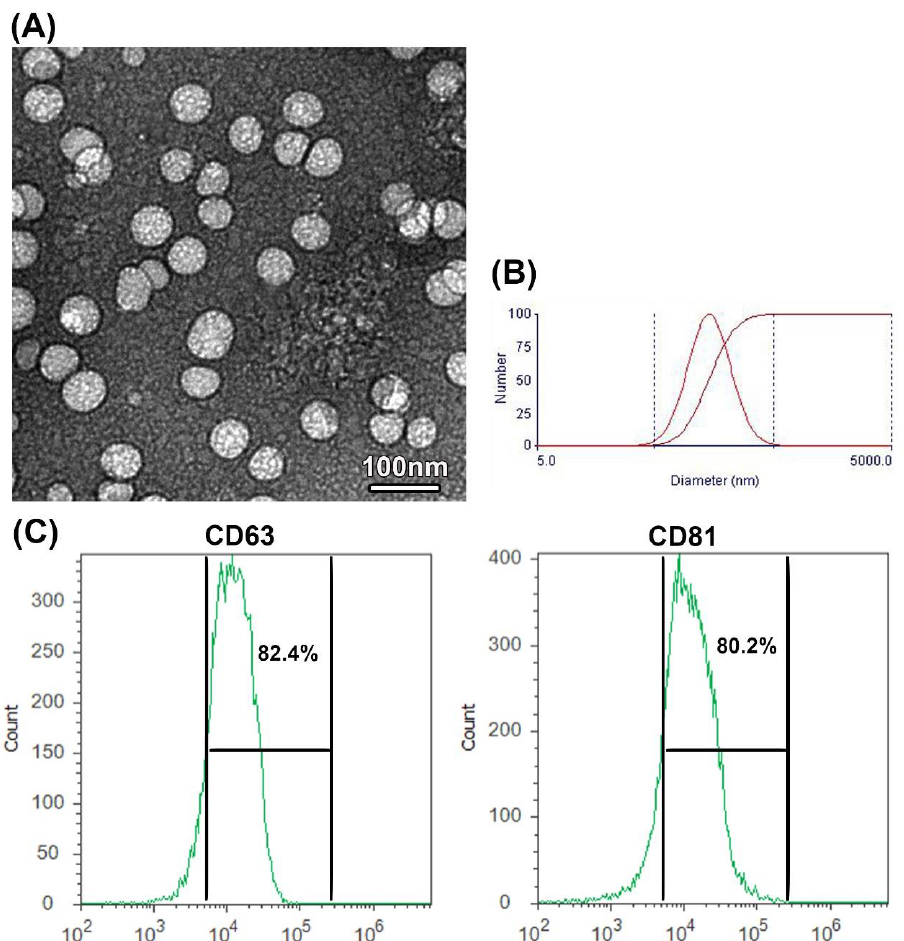
Figure 1. Characterization of EXOs isolated from camel milk. ( A ) TEM photograph shows camel milk-derived EXOS isolated by differential ultracentrifugation, scale bar = 100 nm. ( B ) DLS photograph shows camel milk EXOs with various sizes ranging from 35 to 130 nm. The first curve indicates the differential distribution, and the second curve indicates the cumulative distribution ( C ) Detection of specific exosome proteins by flow cytometry showing percentage of positive exosomal CD63 and CD81 proteins.